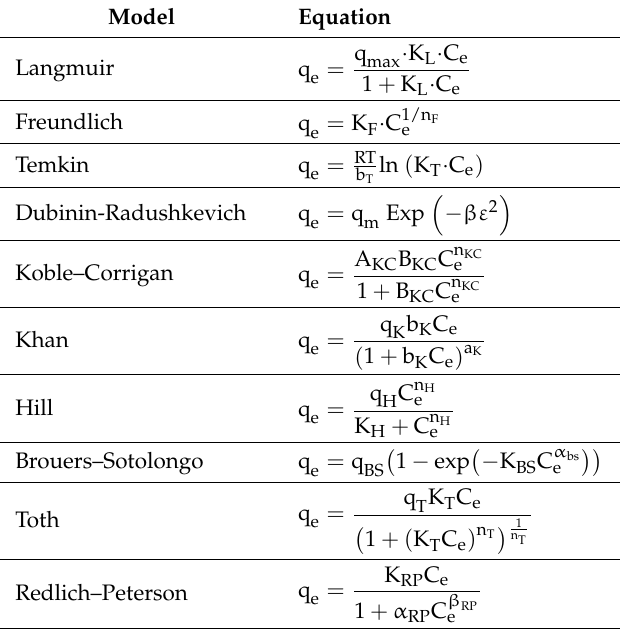
Table 4. Equilibrium